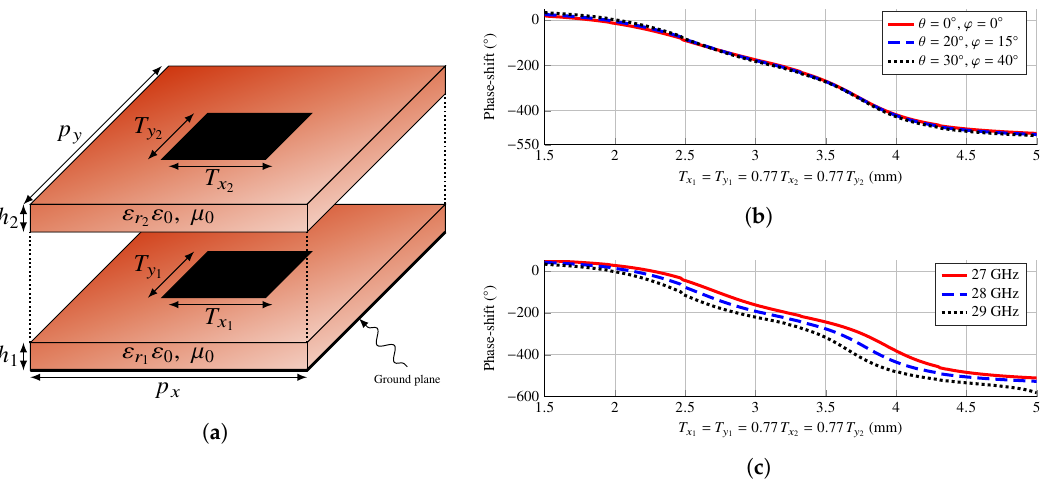
Figure 6. ( a ) Sketch of the employed unit cell, consisting of two stacked rectangular patches backed by a ground plane. The periodicity is p x = p y = 5.35mm, and both layers use the same substrate from Rogers Co., DiClad 870 with thickness of 30mil; ( b ) phase response of the unit cell for normal and oblique incidence, showing that the unit cell response is stable with the angle of incidence; ( c ) phase response of the unit cell for three different frequencies for oblique incidence with ( θ = 40°, ϕ = 30° ) . For the initial layout design after the POS (see Section 4.3), a fixed relative size of the = 0.77 T = 0.77 T stacked patches is kept, with T x x 2 and T y 1 y 2 . The scaling factors 1